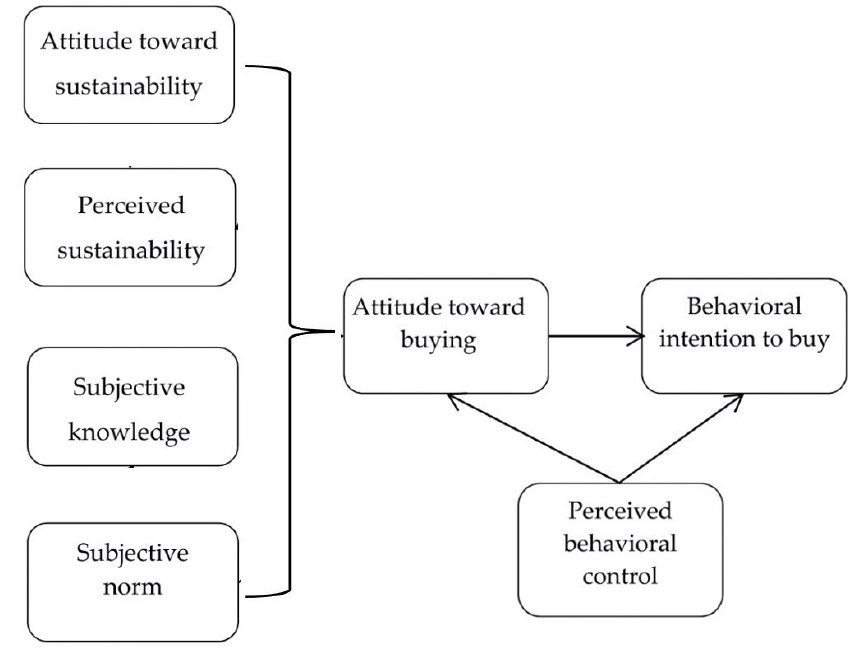
Figure 1. The theory of reasoned action .